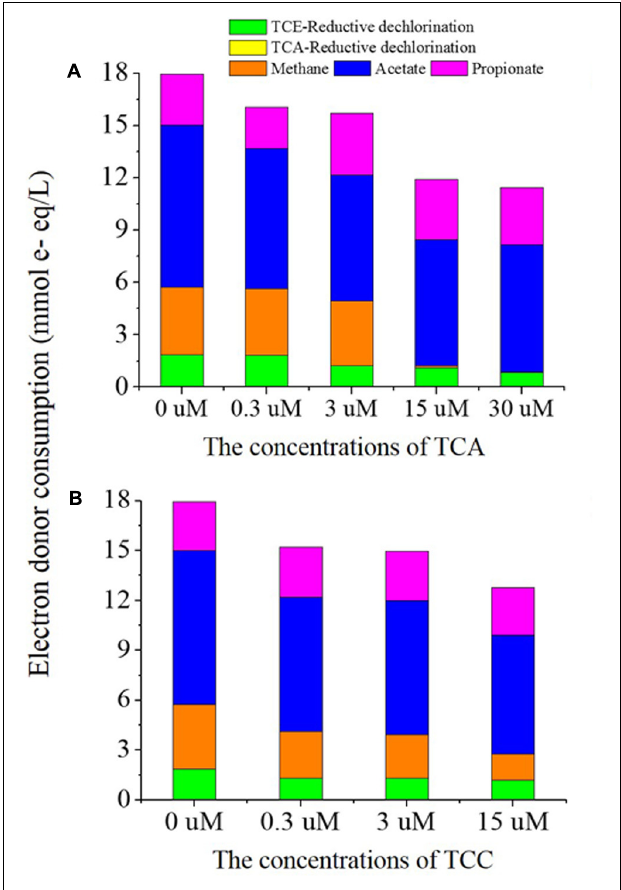
FIGURE 3 | The electron donor consumption of major chemical reactions including reductive dechlorination, methanogenesis, acetogenesis and fermentation in TCA added cultures (A) and TCC added cultures (B) .